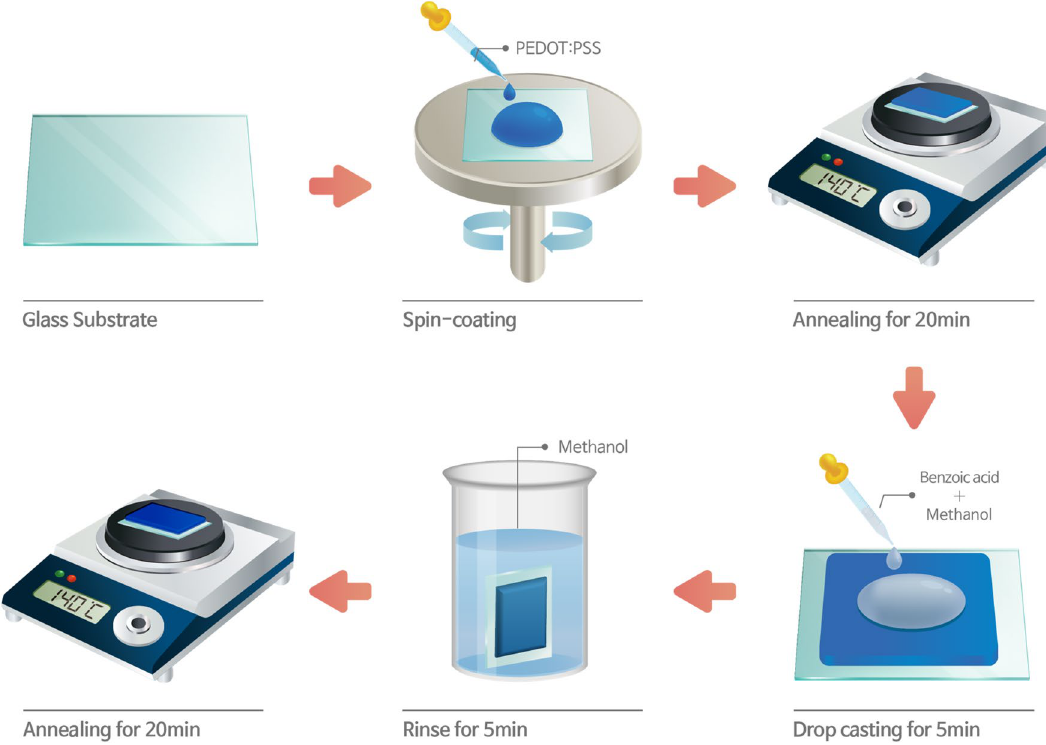
Figure 1. Schematic diagrams of fabrication process for the PEDOT:PSS electrode with benzoic acid treatment (Kang et